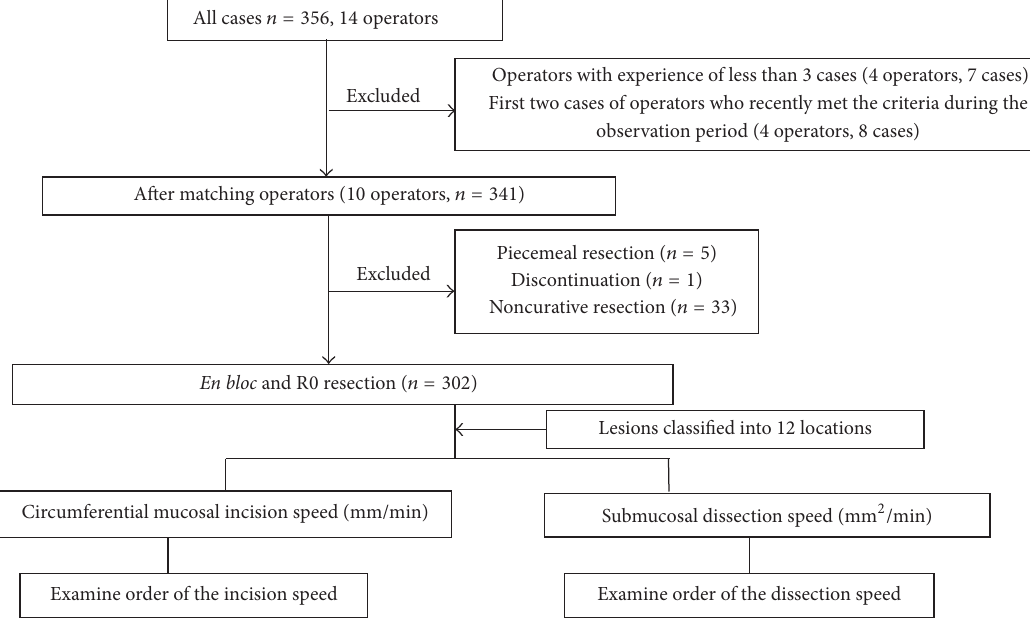
Figure 1: Study outline. Operators newly enrolled during the observation period and their first two